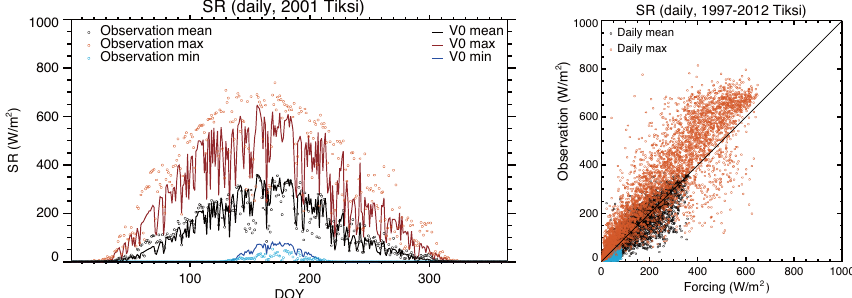
Figure 3. Comparison between level 0 short-wave radiation and observed values. Example shows 1-year time series of daily mean, minima, and maxima during 2001 (left), and scatter plot for all daily data (right) at Tiksi.